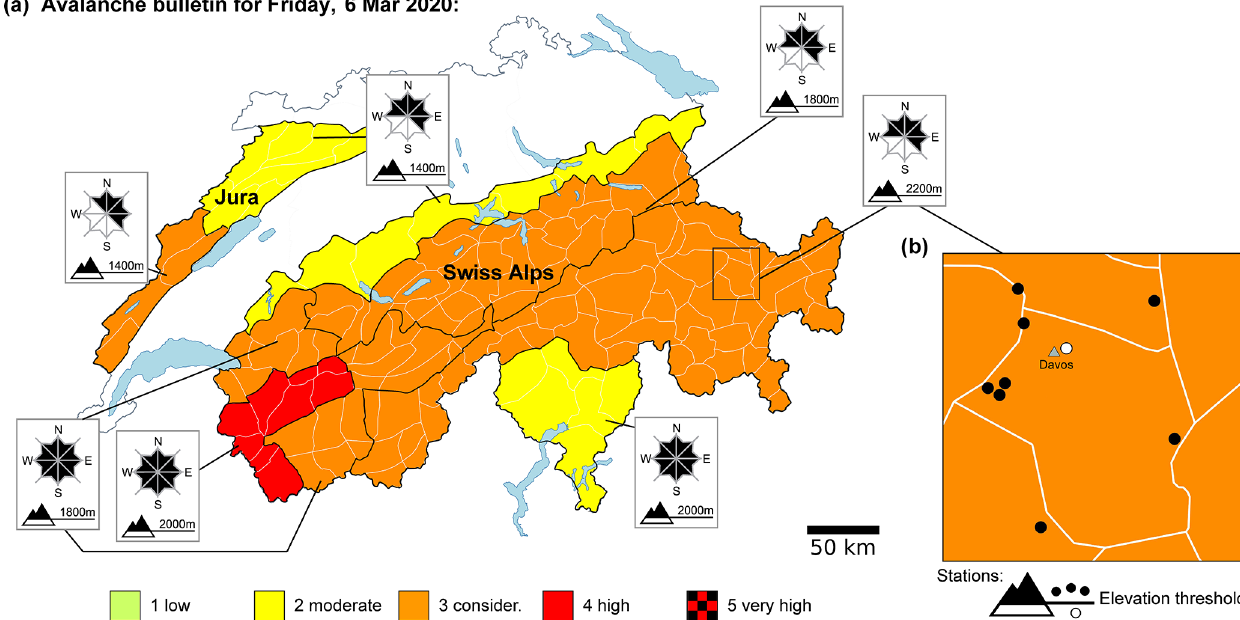
Figure 2. (a) Map of the avalanche danger issued on Friday 6 March 2020 at 08:00LT (local time). For each danger region (black contour lines), a danger level from 1-Low to 5-Very High and the critical elevations and slope aspects are graphically displayed. The white polygons show the 130 warning regions. (b) Close-up map of the warning region Davos, with the location of the IMIS stations (points). To develop the model, we filtered days and stations as a function of the critical forecast elevation (Sect. 3.3), with stations coloured black being above this elevation on this day (here 2200ma.s.l.) and hence considered and the white station, located below this elevation, not